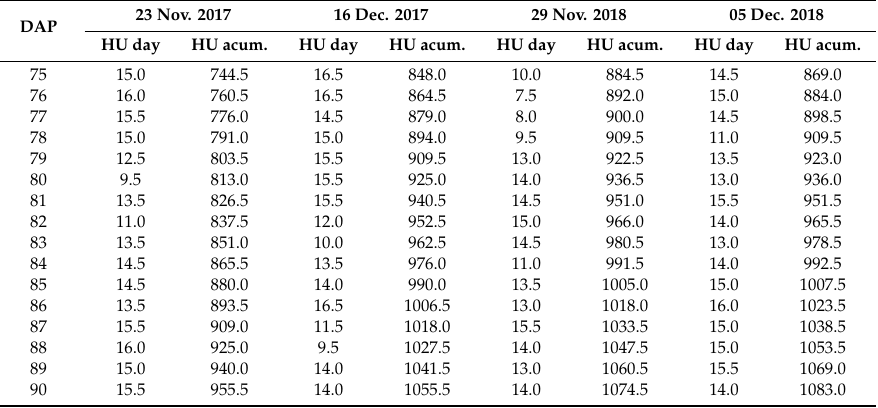
Table A1. Daily and accumulated Heat Units ( ◦ C) from sowing dates to